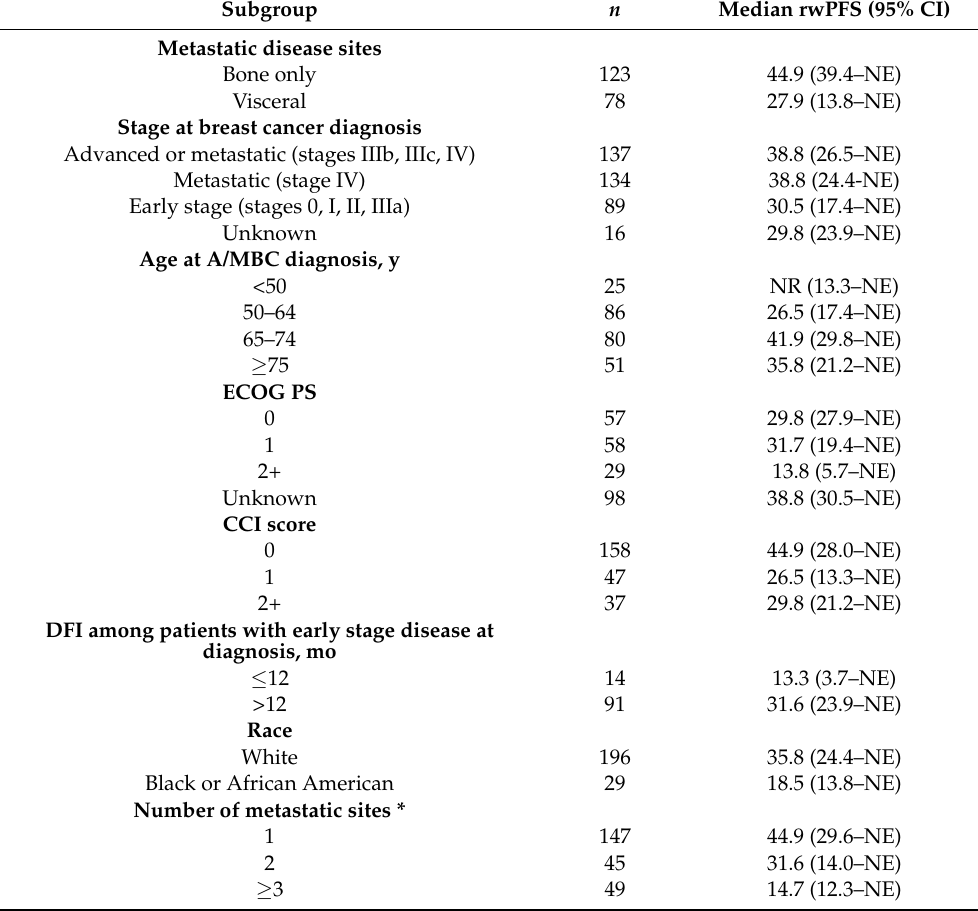
Figure 3. Kaplan-Meier curve of real-world progression-free survival ( A ) among all patients and ( B ) among patients with stage IV disease at breast cancer diagnosis. AI = aromatase inhibitor; PAL = palbociclib; rwPFS = real-world progression-free survival. Table 4. Real-world progression-free survival by